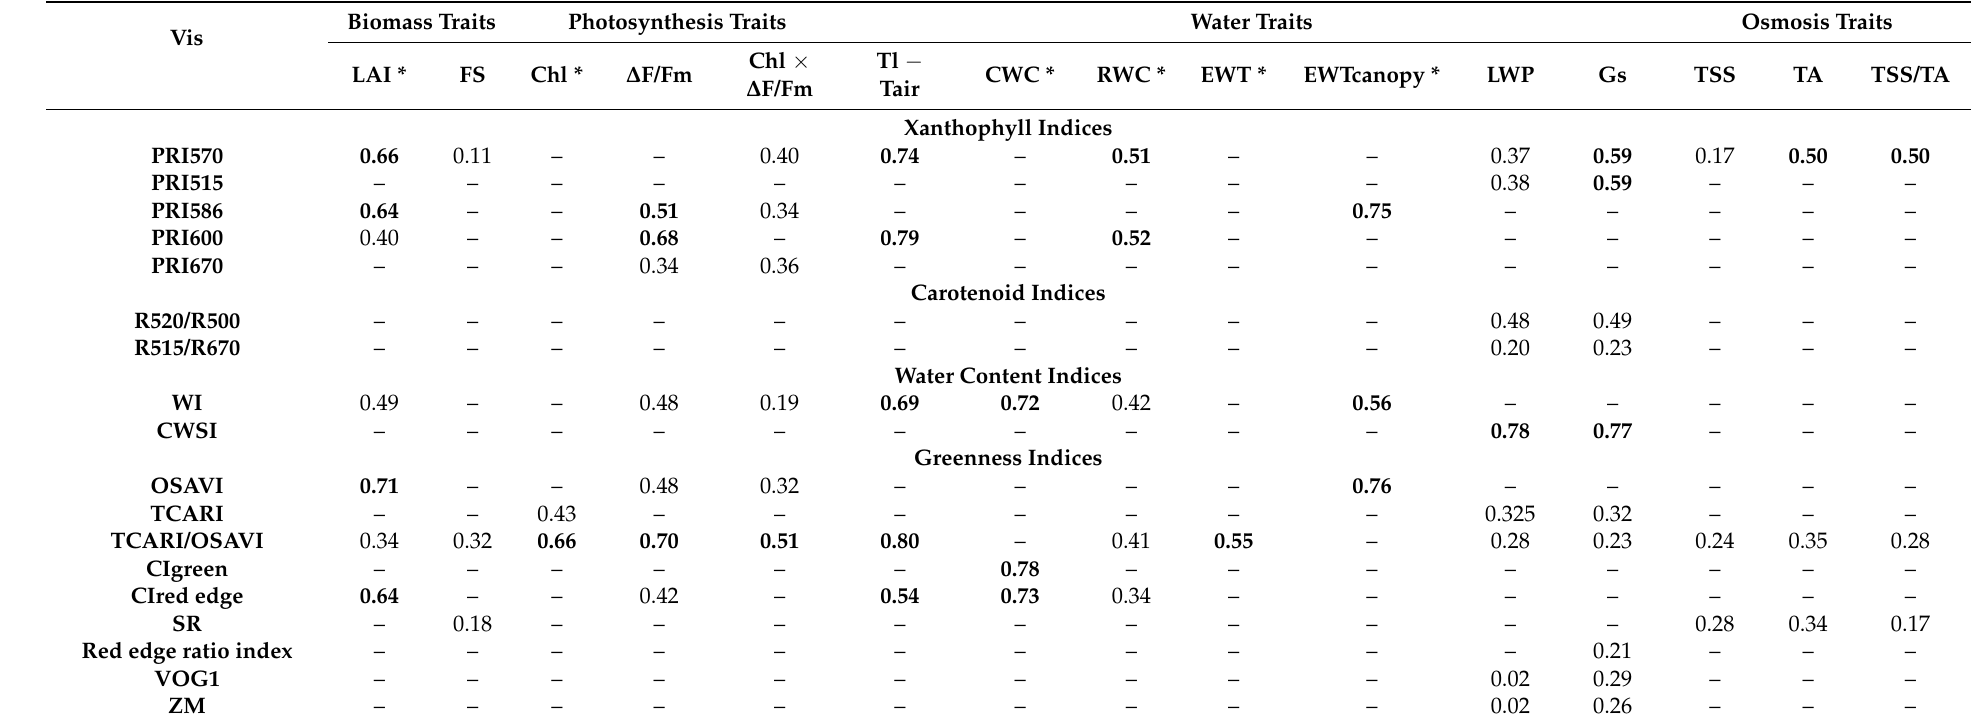
Table 3. The relationship between traits and VIs under drought